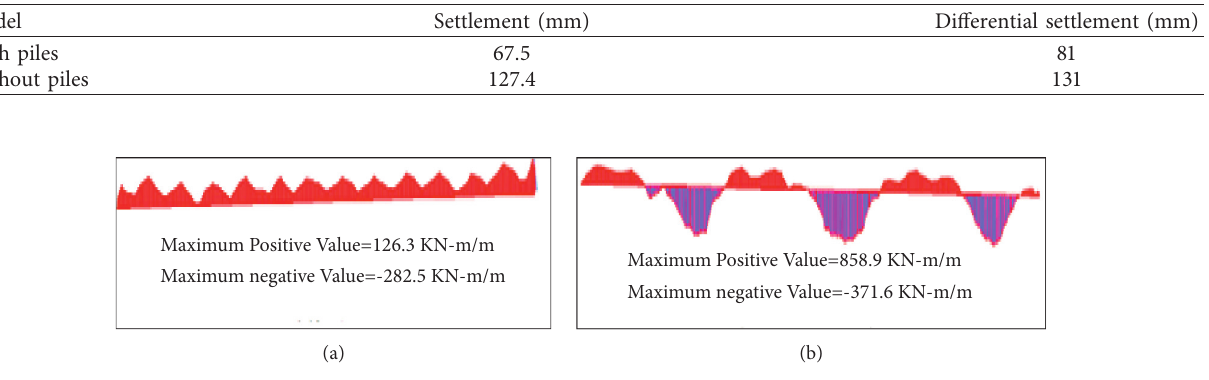
Figure 8: Cross-section for M11 moment on two-story side: (a) with piles; (b) without piles.